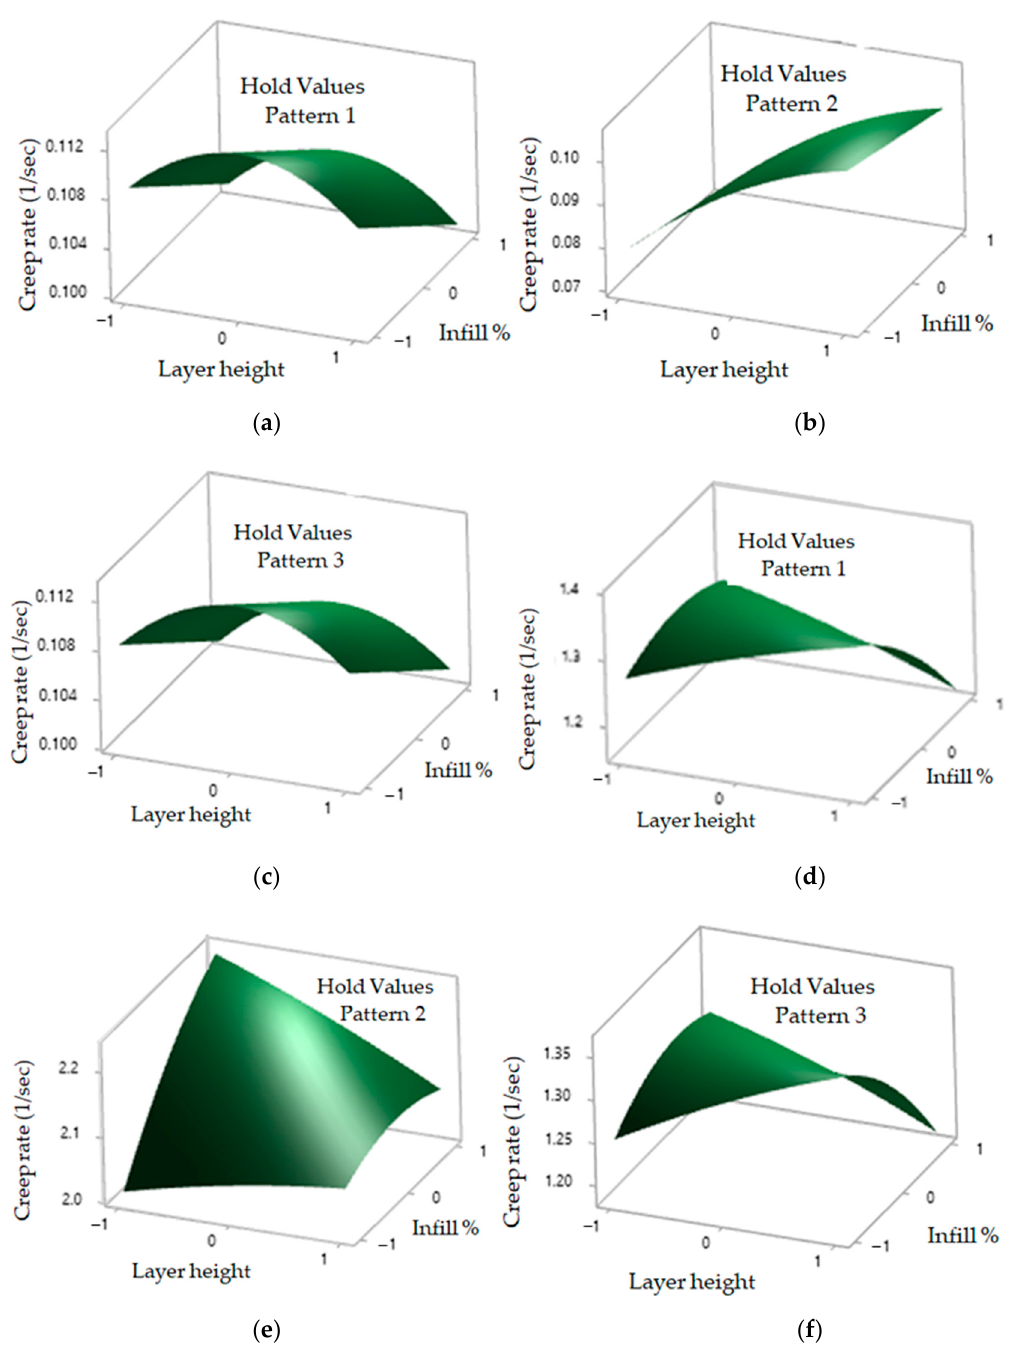
Figure 7. Interaction between layer height and infill %. ( a ) Creep rate of linear patterns. ( b ) Creep rate of hexagonal patterns. ( c ) Creep rate of diamond patterns. ( d ) Rupture time of linear patterns. ( e ) Rupture time of hexagonal patterns. ( f ) Rupture time of diamond patterns.